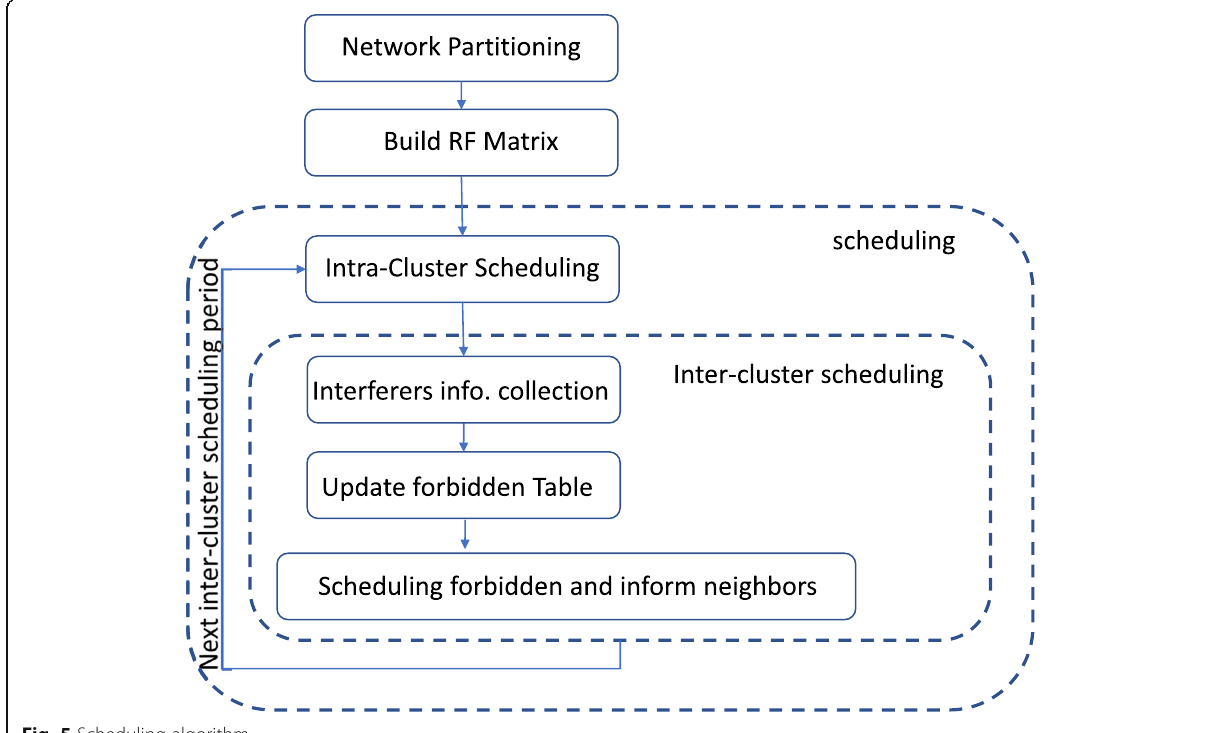
Fig. 5 Scheduling